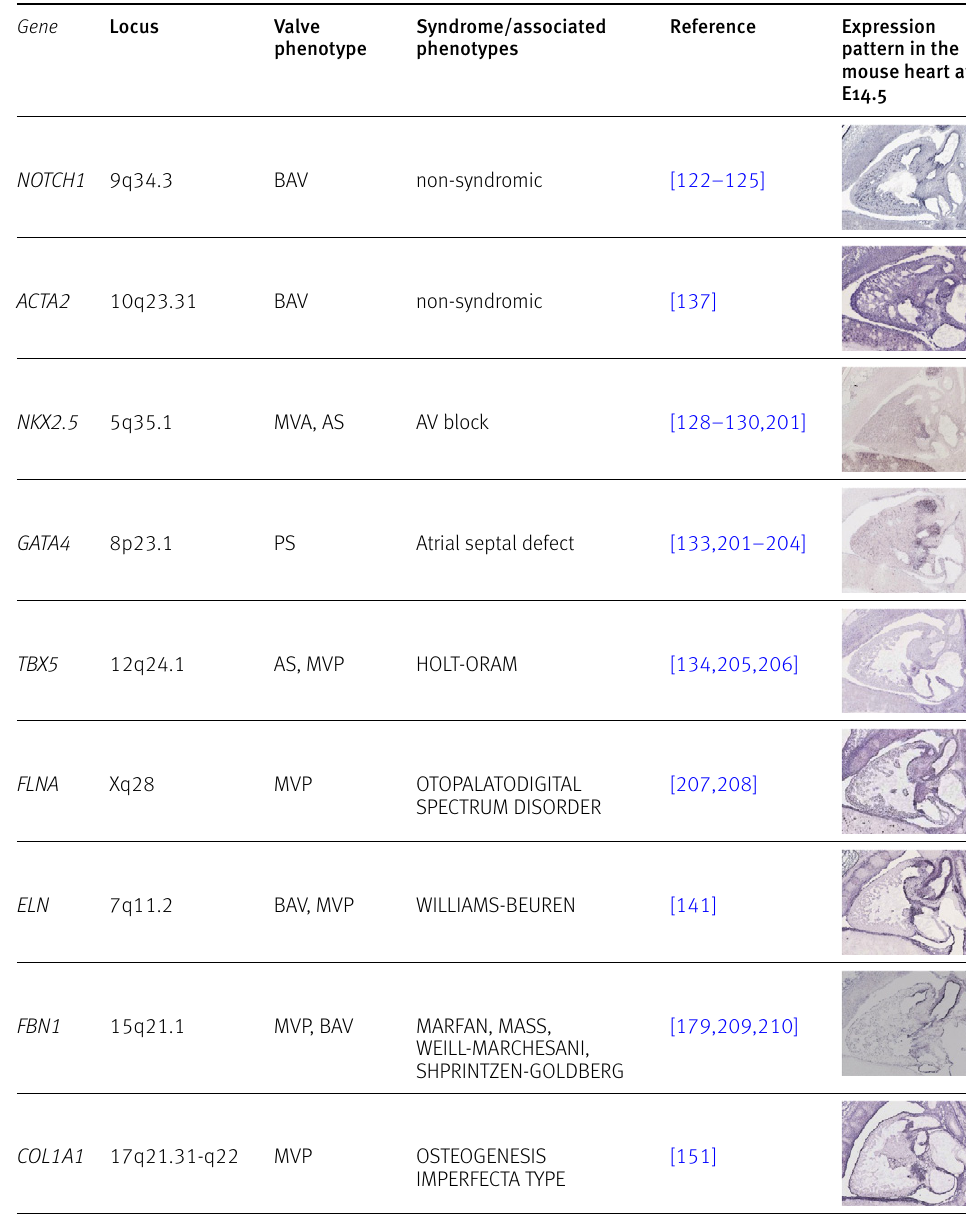
Table 1. Mutated human genes with valvular defects and its cardiac expression pattern at E14.5 in mouse embryos. All of the depicted genes show a localized expression in the endothelium and the valves, highlighting the importance of these genes in valve development. Pictures are taken from www.eurexpress.org [213]. Abbreviations: Mitral valve prolaps (MVP), Pulmonal stenosis (PS),